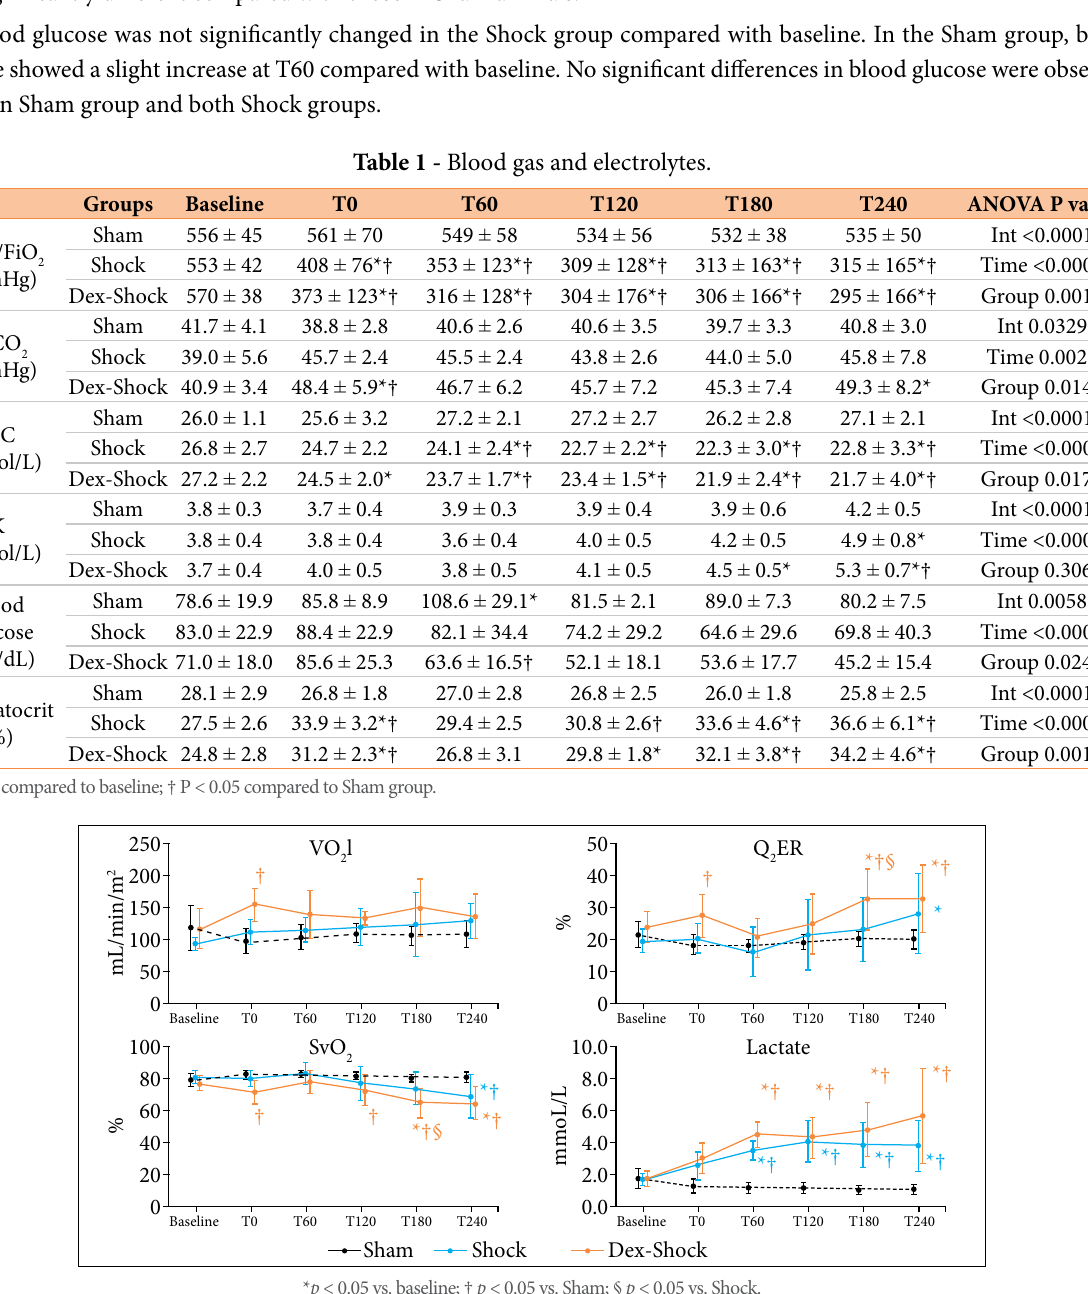
Figure 5 - Changes in oxygen consumption (VO I), the oxygen extraction ratio (O ER), mixed venous oxygen saturation 2 2 (SvO ), and plasma lactate in anaesthetised pigs (Sham group), septic shock animals (Shock group), and septic 2 shock plus dexmedetomidine infusion animals (Dex-Shock group) at baseline; at the end of bacterial infusion (T0); and after 60 (T60), 120 (T120), 180 (T180), and 240 minutes (T240) after bacterial